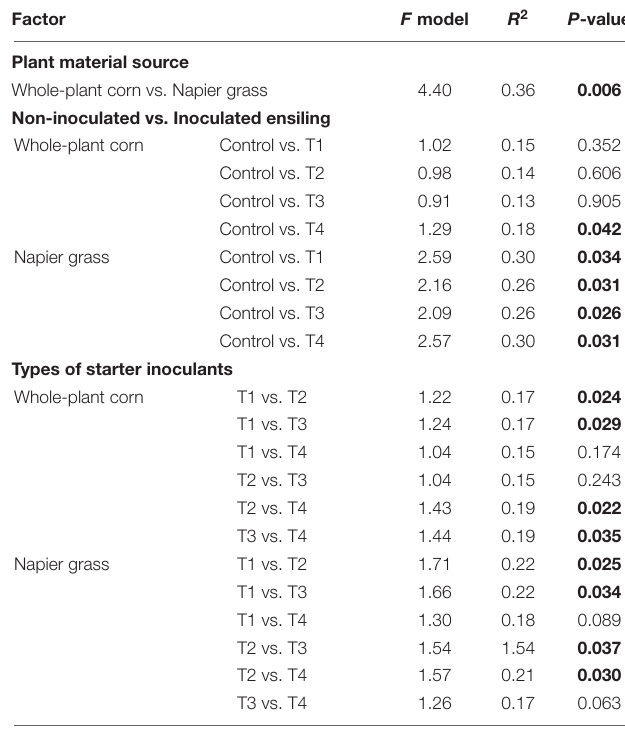
TABLE 5 | Permutational Multivariate Analysis of Variance (PERMANOVA) on bacterial community associated with corn plant and Napier grass